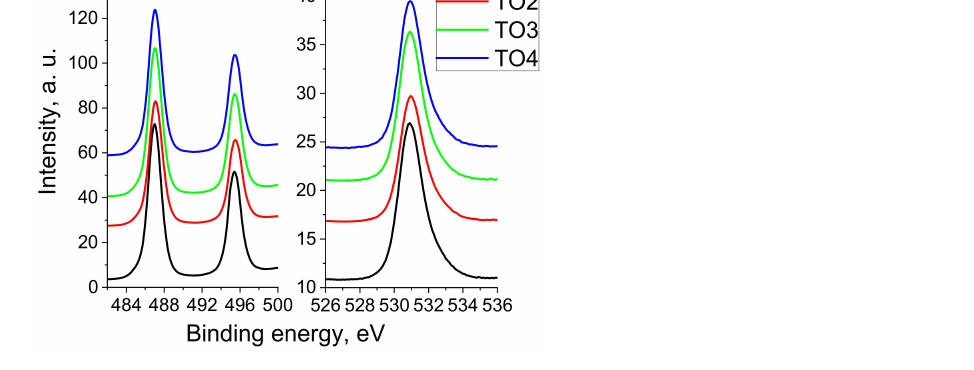
Figure 4. XPS data on Sn3d (left) and O1s (right).